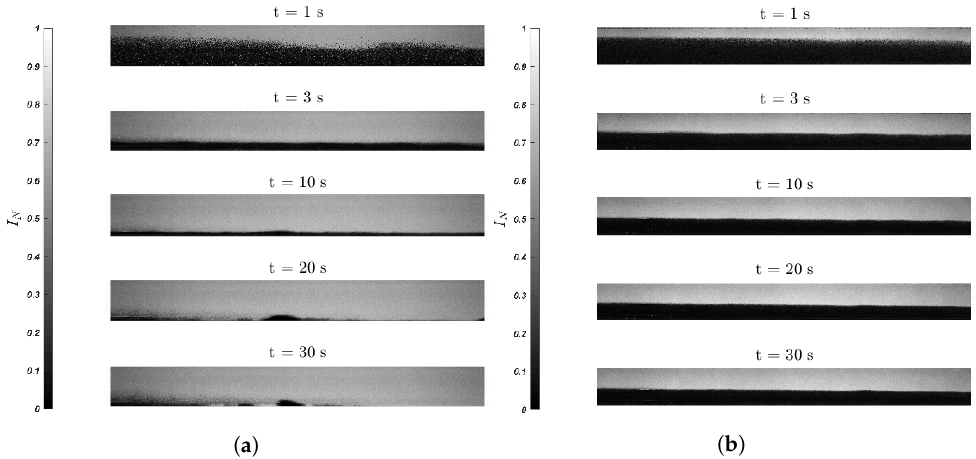
Figure 12. Displacement of Carbopol with ( a ) water in the turbulent regime (Experiment 1) and ( b ) the xanthan solution in the transitional regime (Experiment 3) in an imposed pressure drop condition. See Figure 9b for Experiment 2 in this